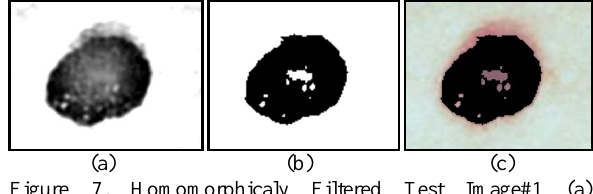
Figure 7. Homomorphicaly Filtered Test Image#1 (a) Photocopy filter (Det: 24, dark:5) (b) Threshold (Level:128) (c) overlay with original